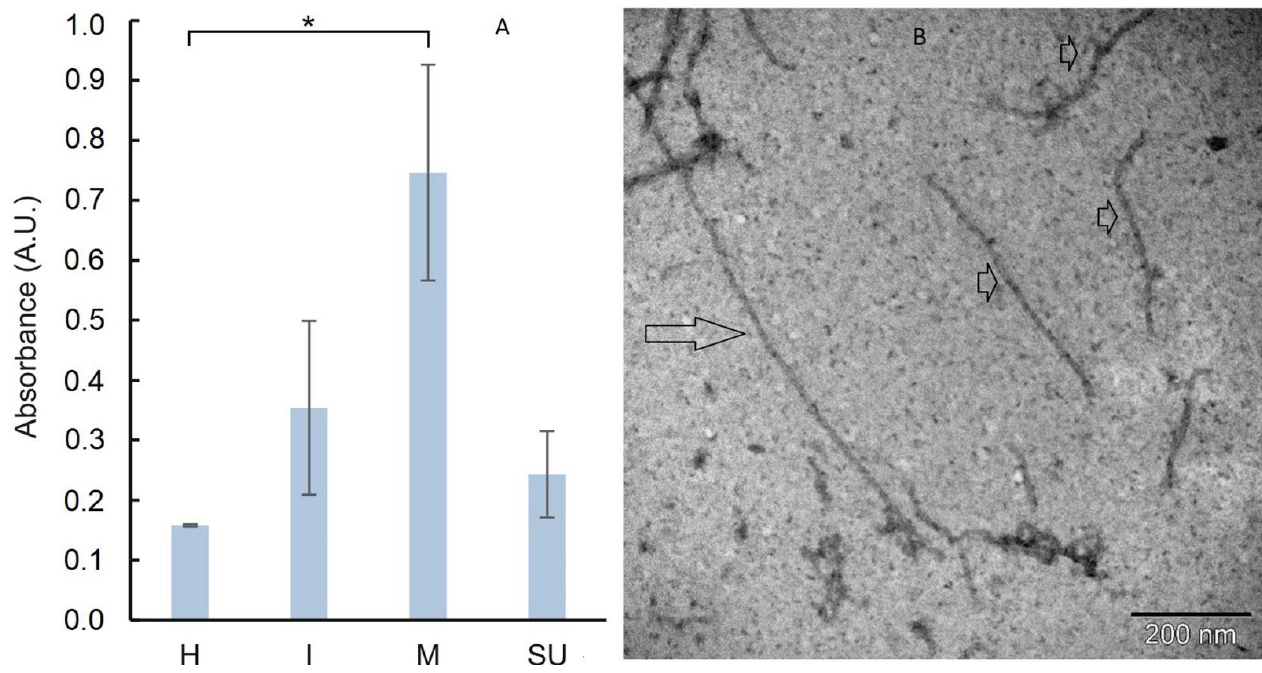
Figure 3. ( A ) PTA-ELISA analysis of PVX CP expression in GFP/pGBX inoculated plants at 21 dpi. The PVX CP was mainly present in the middle part of the plant. Means and standard deviations are presented. Asterisk indicates statistical significance. *, p < 0.05 ( t -test: paired two-sample for means). H, healthy leaves; I, inoculated leaves; M, systemic middle leaves; SU, systemic four upper leaves. ( B ) Electron microscopy of PVX particles (small arrow — single particle around 515 nm × 13 nm and larger arrow — the aggregated particles), isolated from systemic GFP/pGBX leaves of N. benthamiana . This confirms that the deleted version of PVX CPs also forms viral particles. Bar = 200 nm.